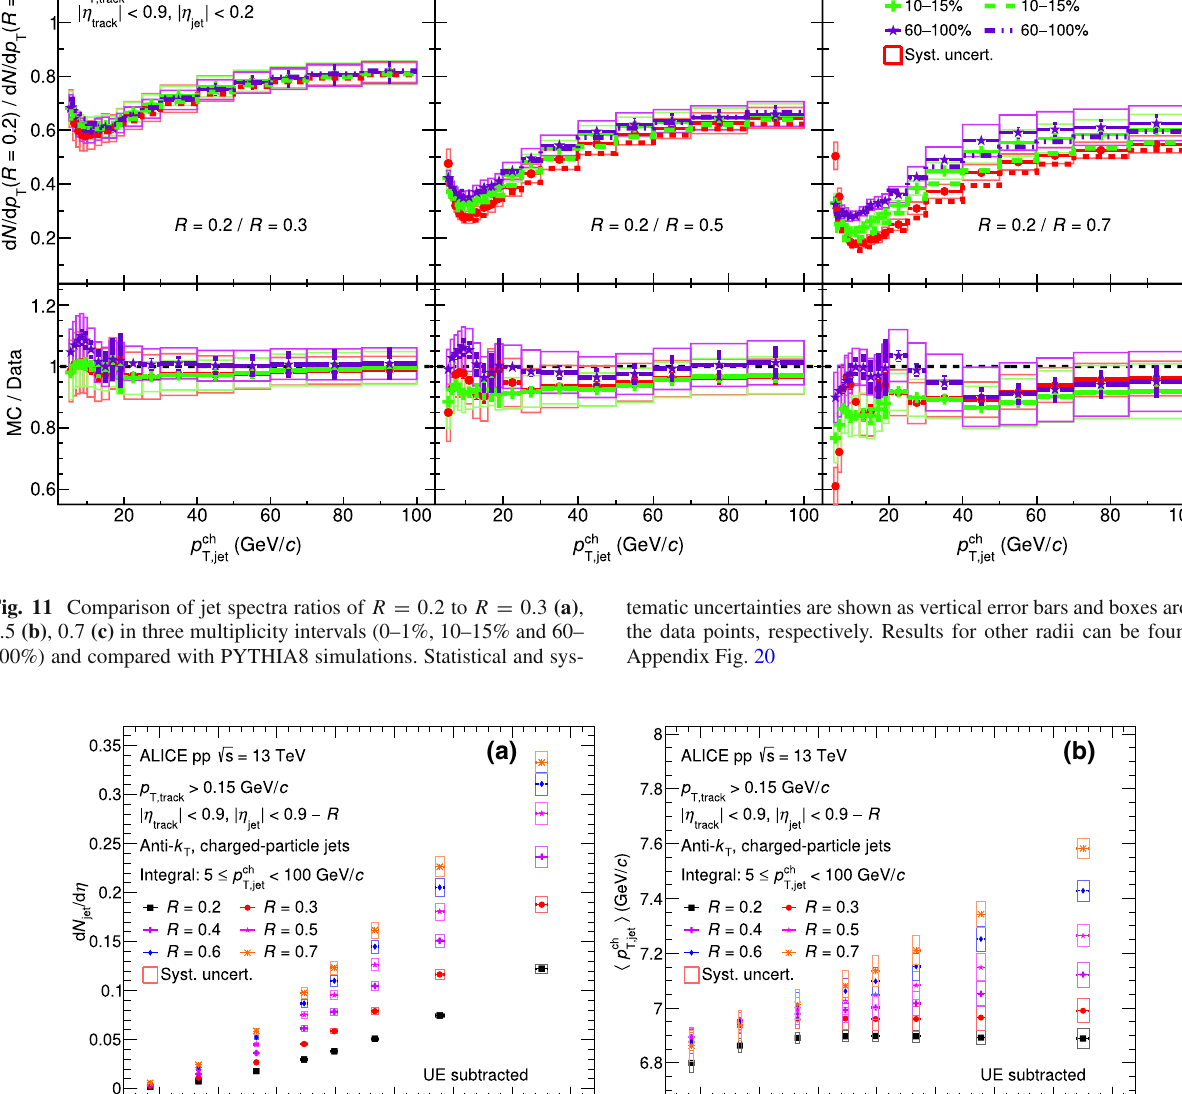
Fig. 12 Integrated jet yields (a) , and (cid:5) p T (cid:6) (b) of jets with 5 ≤ p ch 100 GeV / c as a function of self-normalised charged-particle multiplic- ity for different resolution parameters R varied from 0 . 2 to 0 . 7, with the